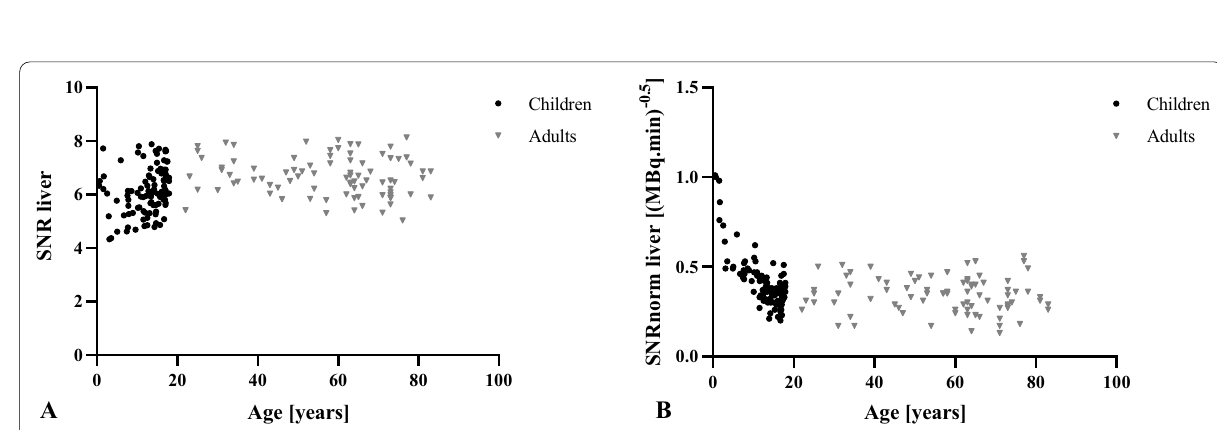
Fig. 1. In children, the correlation between SNR liver and SNRnorm liver showed no correlations with age of, respectively, r -0.138, n 85, p 0.208 and r -0.092, = = = = n 85, p 0.400. This is in contrast to SNRnorm liver in = =